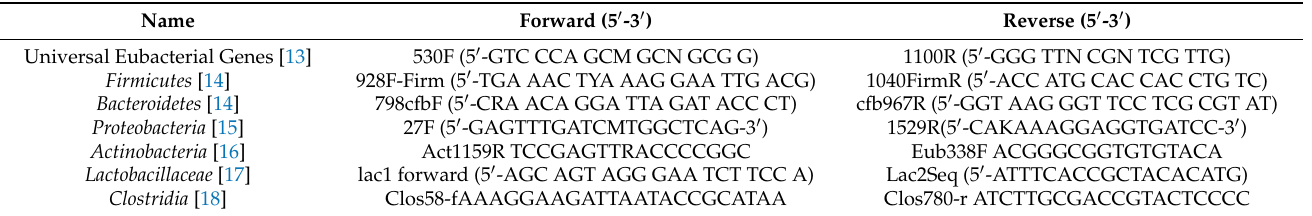
Table 1. Primers used during RT–PCR